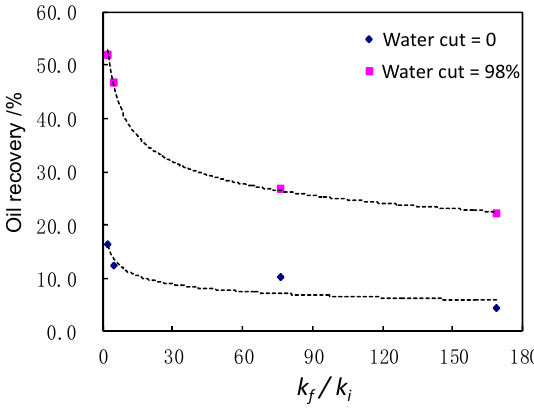
ff erent permeability ratios at di ff erent water Figure 11. Oil recovery variations with different permeability ratios at different water cuts. Figure 11. Oil recovery variations with di